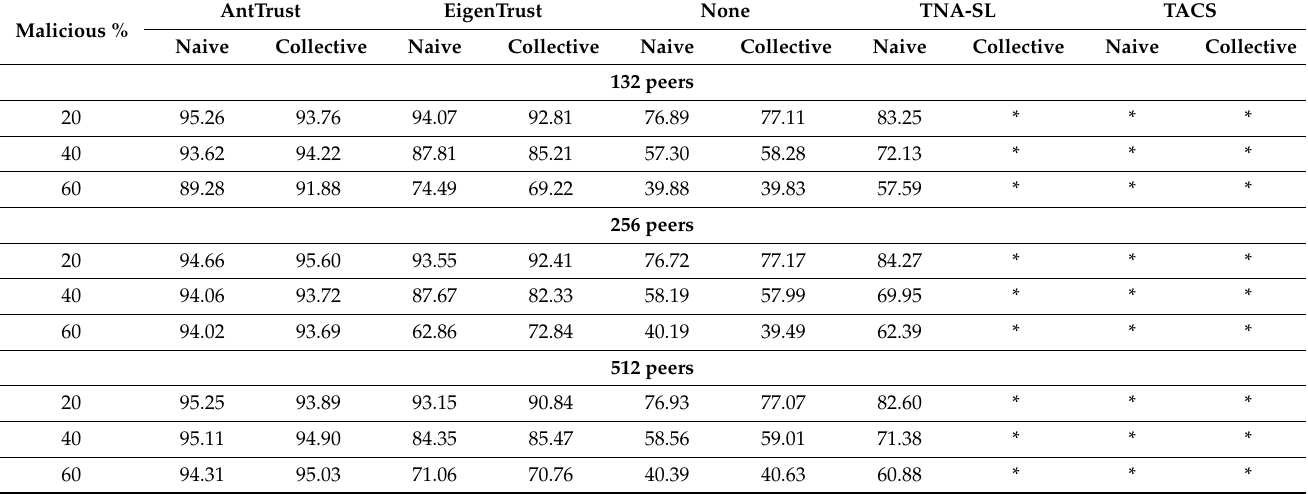
Table 3. The success rate for 5000